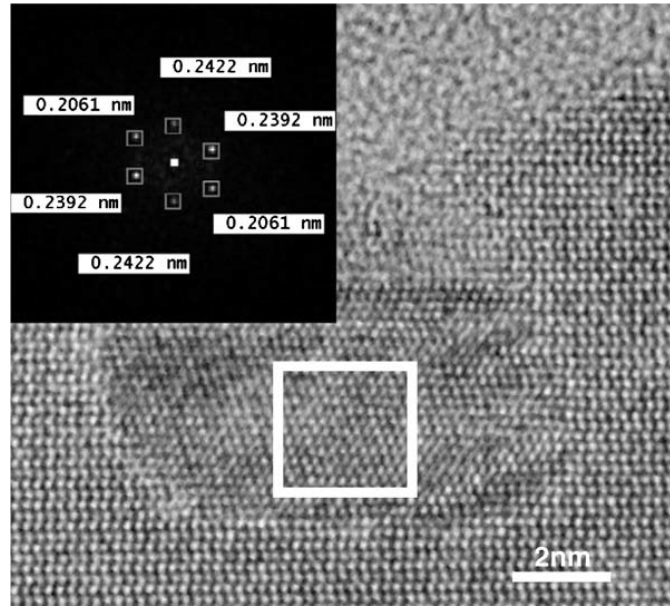
Figure 12. CrN nanocluster embedded in Ga 0.97 Cr 0.03 N probed by HRTEM and identified from the SADP shown in the inset. Reproduced with permission from Reference